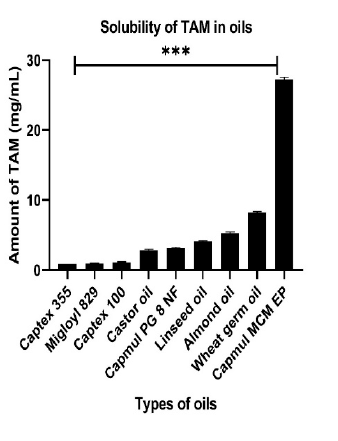
Figure 2. Cytotoxicity of TAM and RES combination in different ratios (1:1; 1:5; 1:10). Data are given as mean ± standard deviation ( n = 3) with statistical difference at (**) p < 0.01.